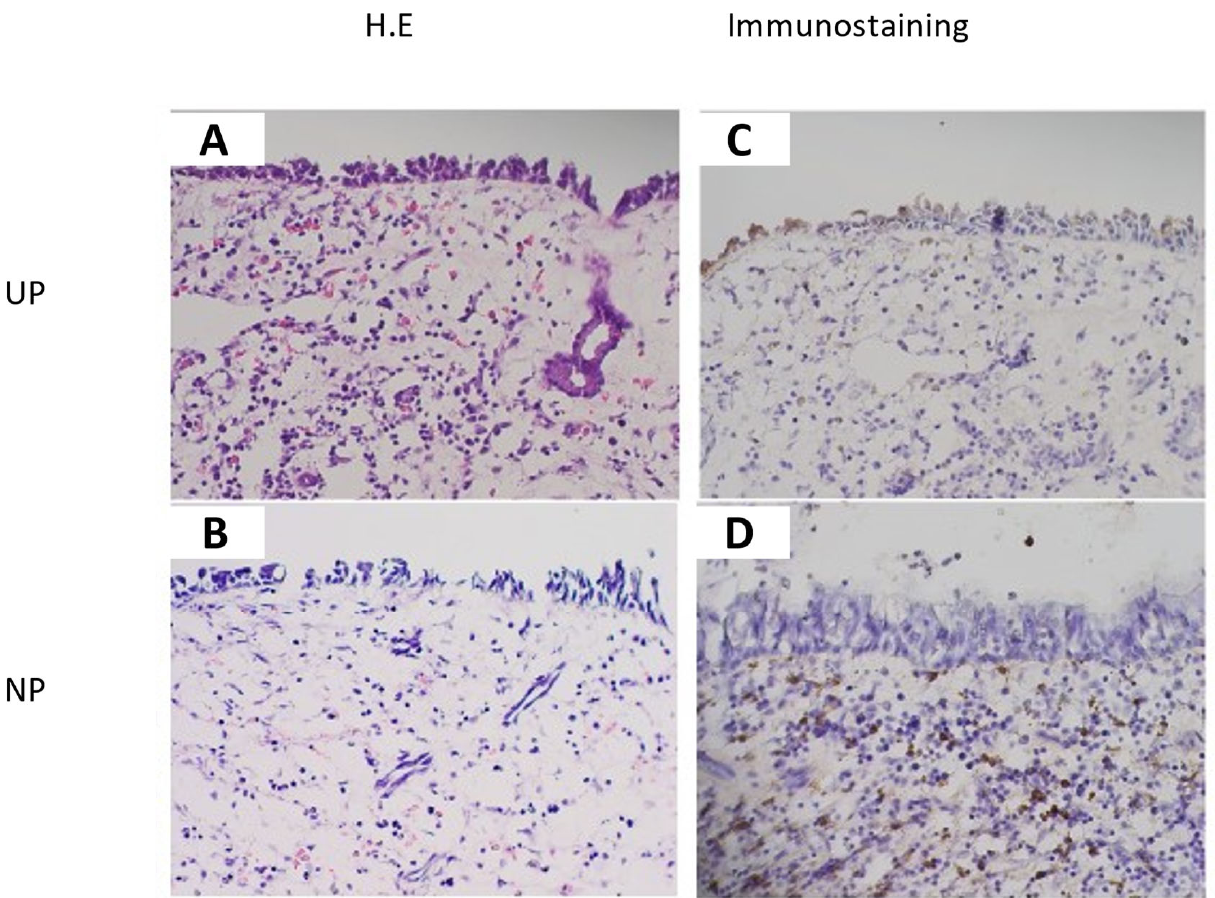
Figure 3. Immunohistochemical images of UP (control) ( A , C ) and NP (CRSwNP) ( B , D ) (original magnification × 200). TGM 1 production was recognized in epithelial cells and inflammatory cells in the submucosal layer in UP (control) ( C ) and inflammatory cells in the submucosal layer in Np (CRSwNP) ( D ), and it was weakly recognized in the connective tissue in UP (control) ( C ) and NP (CRSwNP) ( D ). The location of TGM 1 positive inflammatory cells in the submucosal layer in UP (control) and NP (CRSwNP) were similar to the location of eosinophil in hematoxylin-eosin (H.E) stains ( A , B ). The degree of positive cells on TGM 1 in the submucosal layer was suggested to be comparatively higher in NP than in UP (control) associated with the degree of eosinophil infiltration ( C , D ).